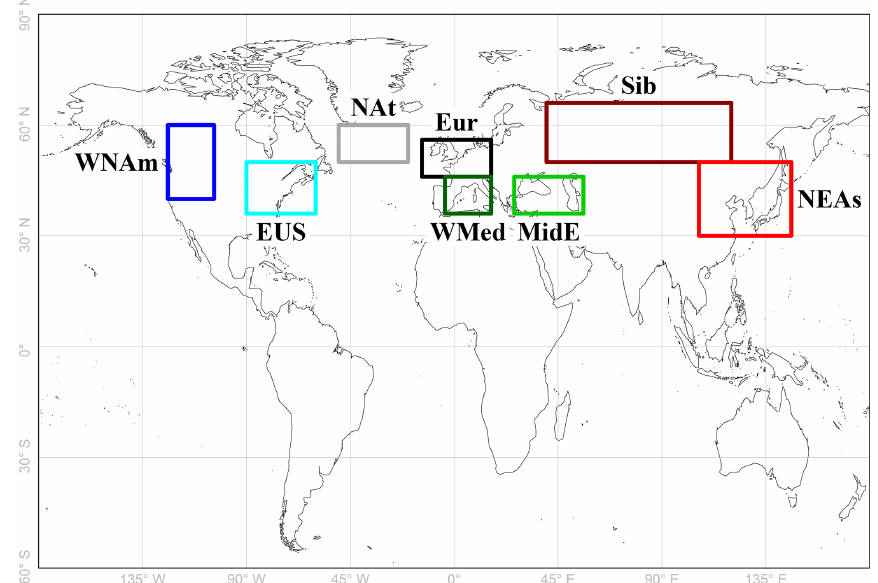
Figure 2. Map of the regions selected for this study based on Cohen et al. (2018), adapted to the MOCAGE global grid. From west to east, the acronyms stand for western North America, the eastern United States, northern Atlantic, western Europe, western Mediterranean Basin, the Middle East, central Siberia and northeastern